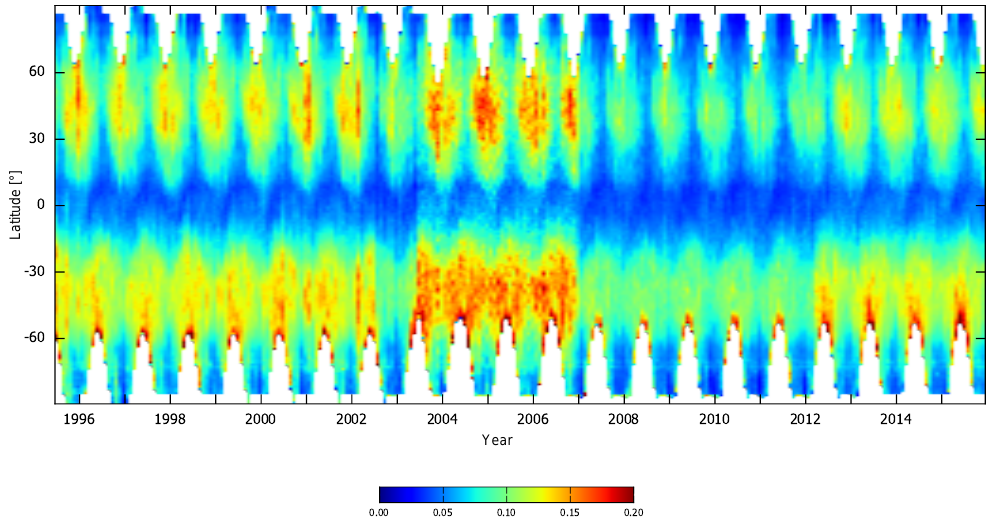
√ N and thus highest